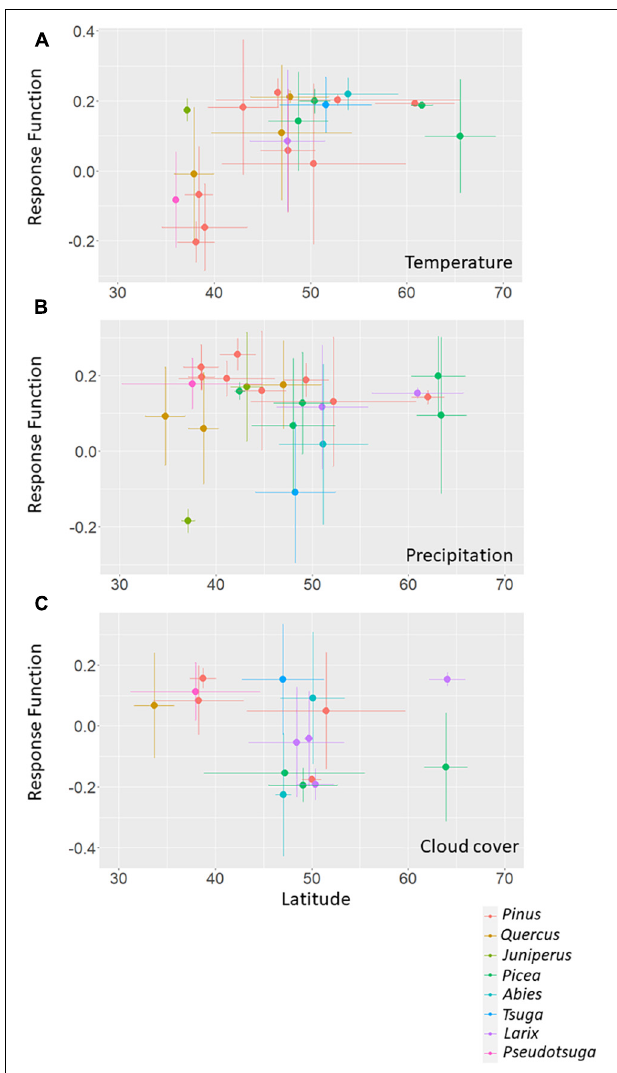
FIGURE 4 | Relationship between the latitude and the response function (RF) coefficients for (A) temperature, (B) precipitation, and (C) cloud cover, in autumn season. Both the site latitude and RF coefficient are averaged by tree species. Colors indicate tree genera. To ensure a sufficient number of sites for each tree genera and species, we limited our analysis to RWI sites with tree genera observed at 90 or more sites and with tree species observed at 5 or more sites from those sites with significant RF coefficients for each autumn climate